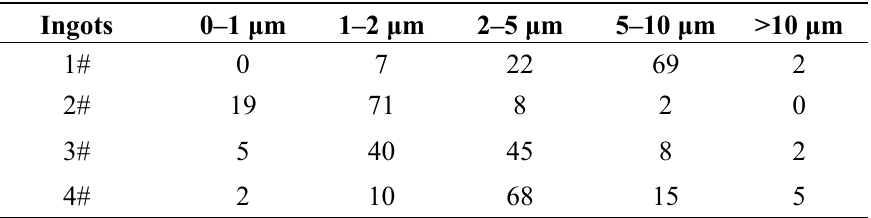
Figure 5. The typical EDS analysis of inclusions without REM ( a ) and after REM addition ( b ). Table 2. The relation of longitudinal length and number percentage of inclusions tested by image statistic analysis